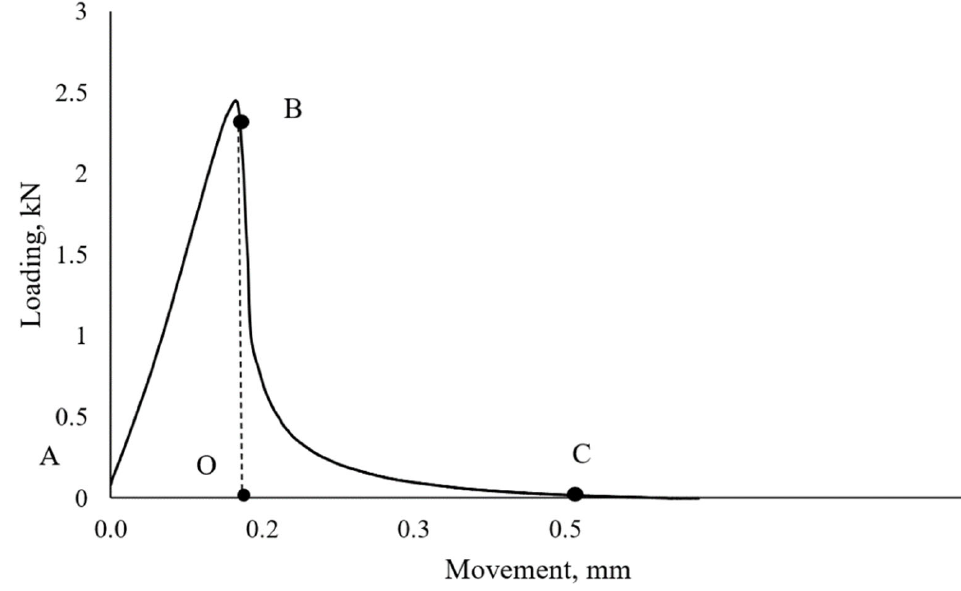
Figure 14. Load–displacement curves of cut faces of plain concrete specimens.